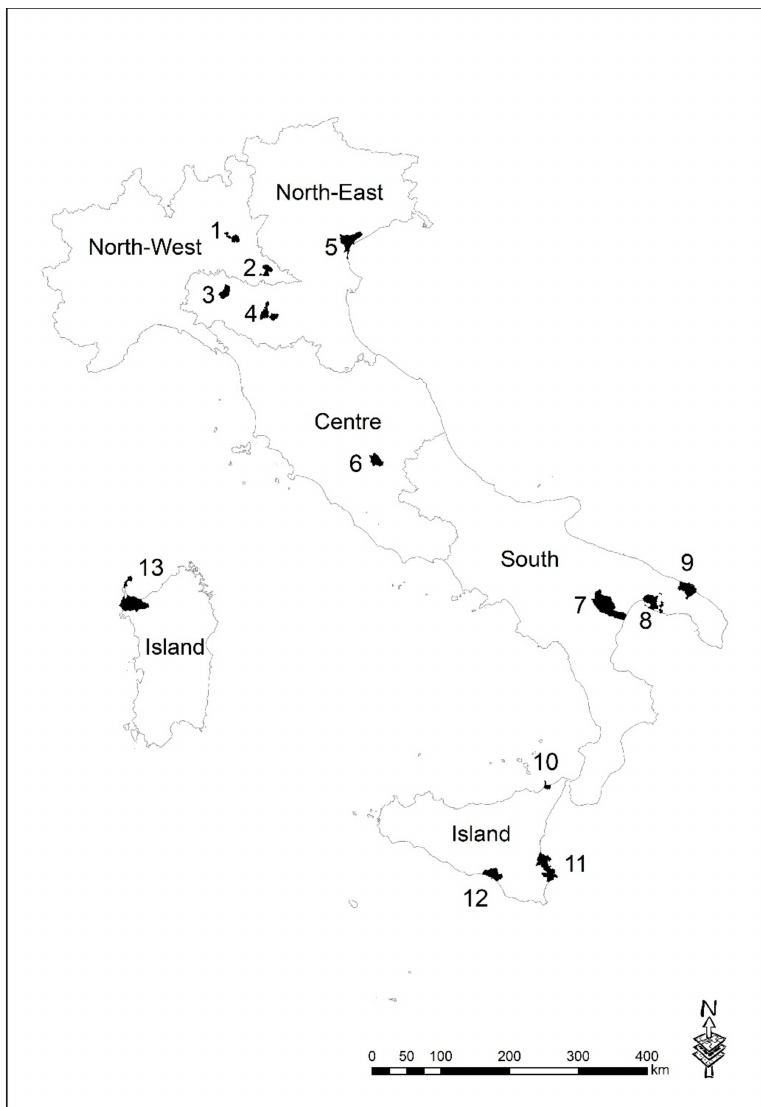
Figure 1. Italian geographical macro areas. National Priority Contaminated Sites (NPCS): 1 = Brescia- Caffaro; 2 = Laghi di Mantova; 3 = Fidenza; 4 = Sassuolo; 5 = Venezia-Porto Marghera; 6 = Terni- Papigno; 7 = Area Industriale Val Basento; 8 = Taranto; 9 = Brindisi; 10 = Milazzo; 11 = Priolo; 12 = Gela; 13 = Area industriale Porto